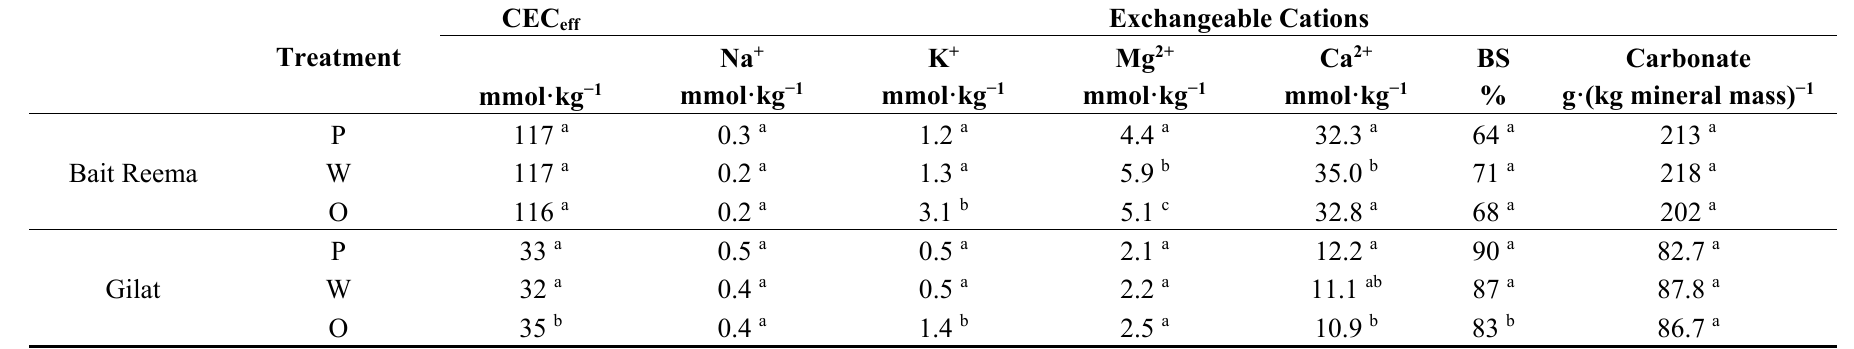
Table 3. Effective cation exchange capacity (CECeff), exchangeable cations, base saturation (BS) and carbonates affected by application of OMW and water in Bait Reema and Gilat pre application (P) and after application of OMW (O) or water (W) during six weeks of sampling. Mean values for the whole study period followed by the same letter are not statistically different in Bait Reema or Gilat. Concerning CEC, only selected samples from each treatment were analyzed. Errors are within the last digit of each value.